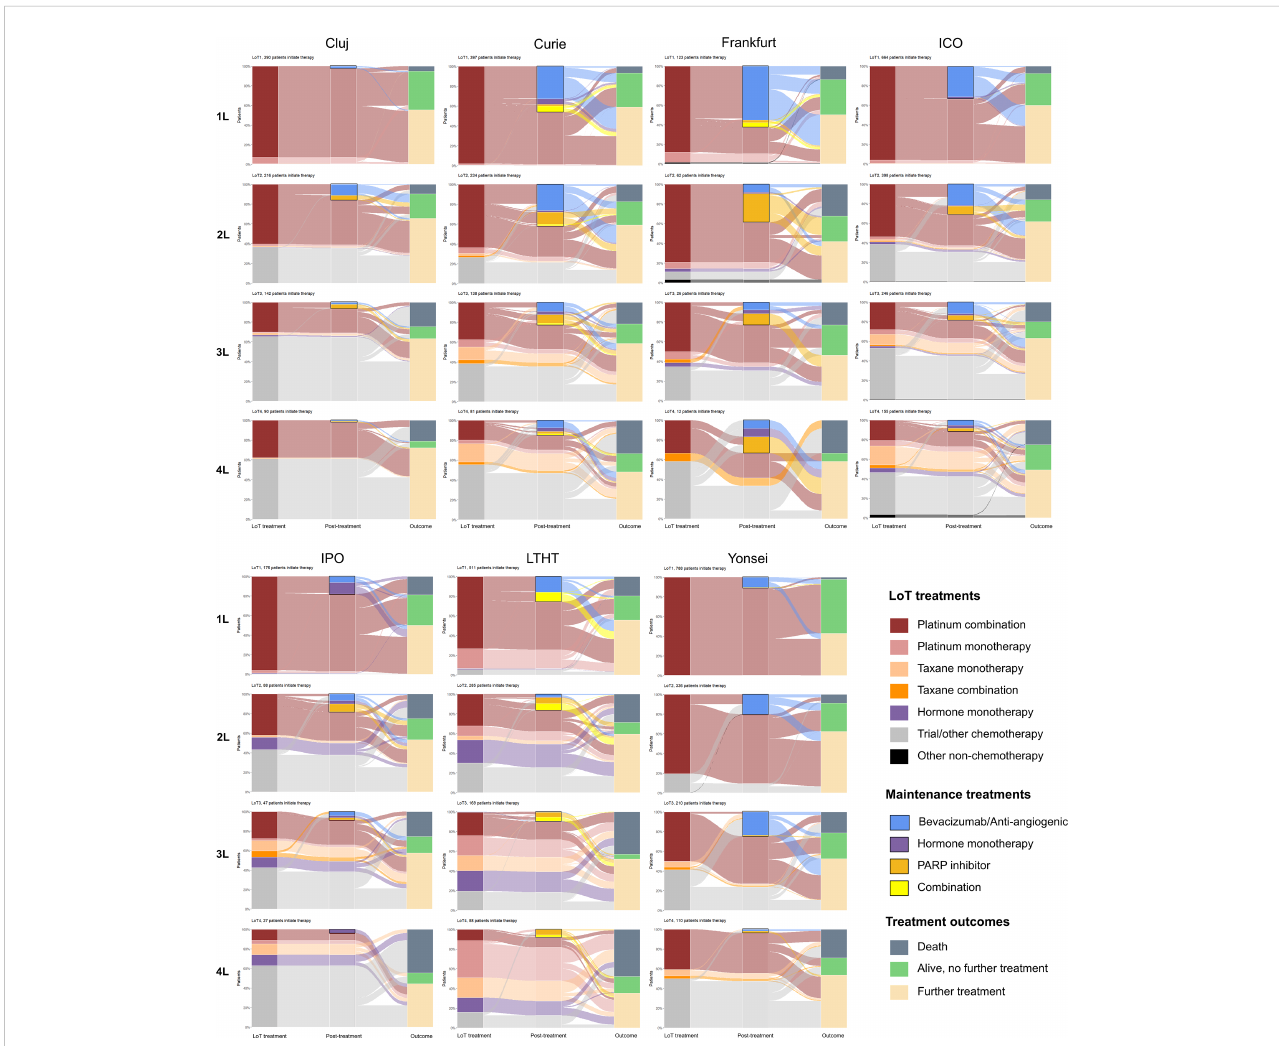
FIGURE 6 Treatment pathways and outcomes for the fi rst 4 lines of SACT treatment (1L to 4L), by study site. Class of treatment regimen is shown in the left-hand column ( ‘ LoT treatment ’ ), subsequent maintenance therapy (where used) is indicated in the middle column ( ‘ post treatment ’ ) by a solid outline and treatment outcome is in the right-hand column ( ‘ outcome ’ ).